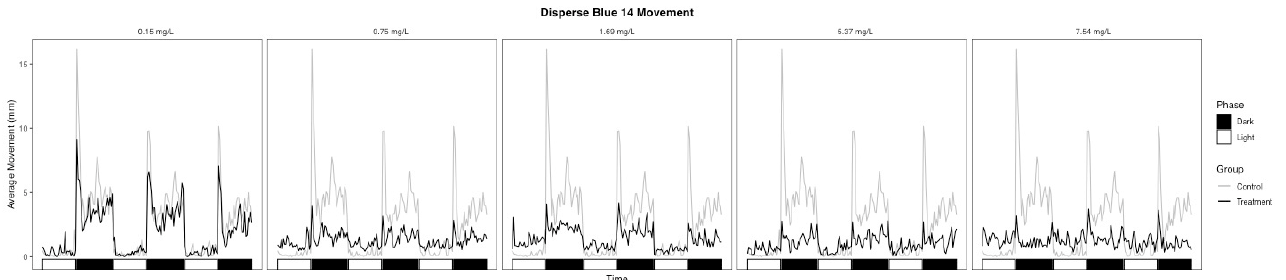
Figure 4. Average movement of Disperse Blue 14 treatment groups throughout the photomotor assay.